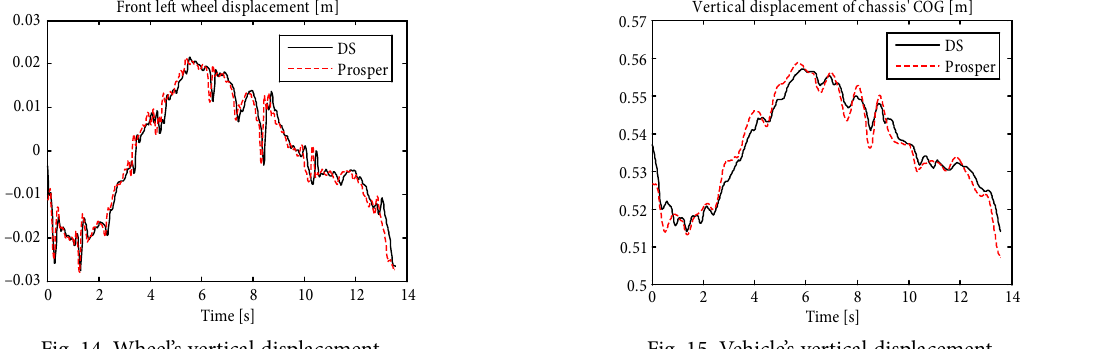
Fig. 14. Wheel’s vertical displacement Fig. 15. Vehicle’s vertical displacement Table 2. New vehicle model’s